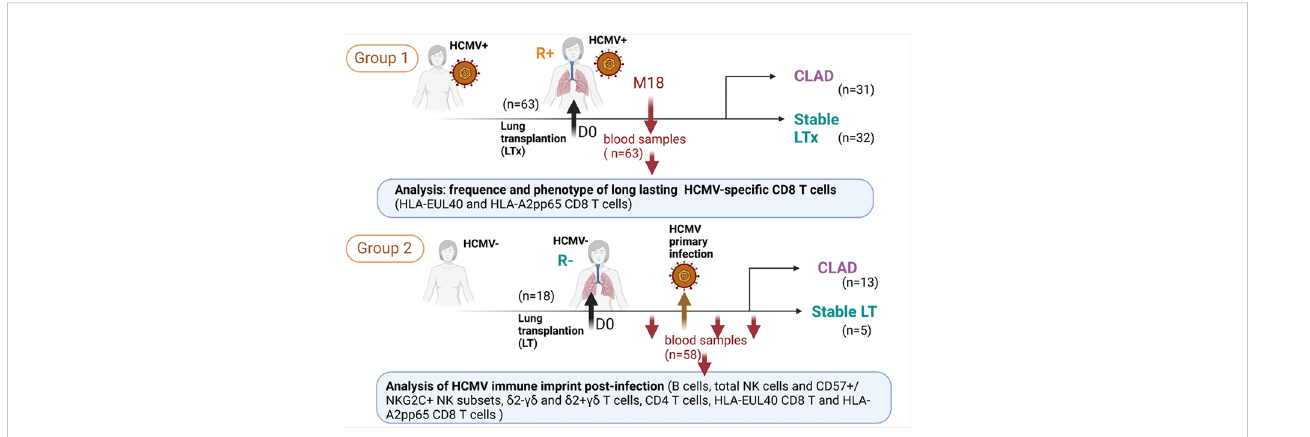
FIGURE 1 Flowchart representing the design of the study and showing the two groups of lung transplant recipients (LTRs) (group 1 and group 2) included and the samples used for the